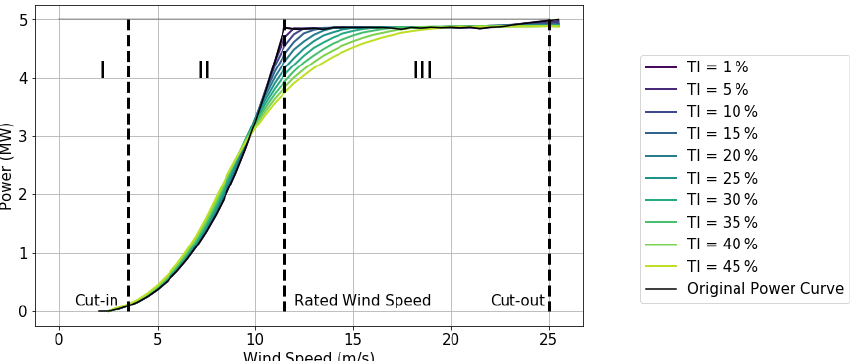
Figure 11. Adjusted power curve for the NREL 5MW reference turbine for different turbulence intensities. The dashed lines denote the cut-in, rated, and cutout wind speeds and also represent the boundaries of the first, second, and third regions,